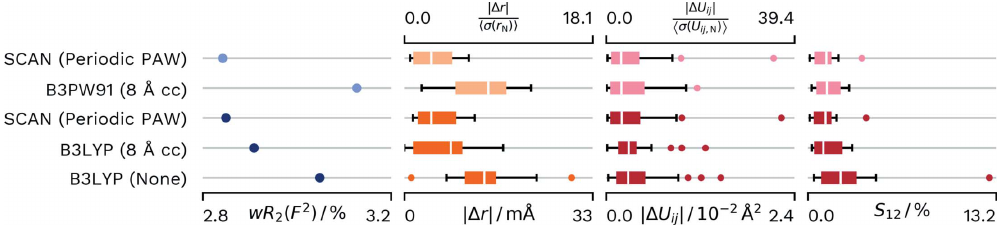
Figure 6 Differences in wR 2 ( F 2 ) and agreement with neutron values for different density sources for HAR of HMa-Mg . Distributions of parameters are displayed as box-whisker plots. SCAN (Periodic PAW) was conducted with our script and GPAW . The B3PW91 (8 A˚ cc) values are from the reference calculation from the literature (Malaspina et al. , 2021 b ) and used 8 A˚ of cluster charges for the crystal approximation. B3LYP (8 A˚ cc) uses 8 A˚ of cluster charges and was refined with NoSpherA2 / TONTO . B3LYP (None) was calculated with NoSpherA2 / ORCA without any approximation of the crystal environment. Lighter coloured datasets have an F / (cid:2) ( F ) cut-off of 4 as applied in the